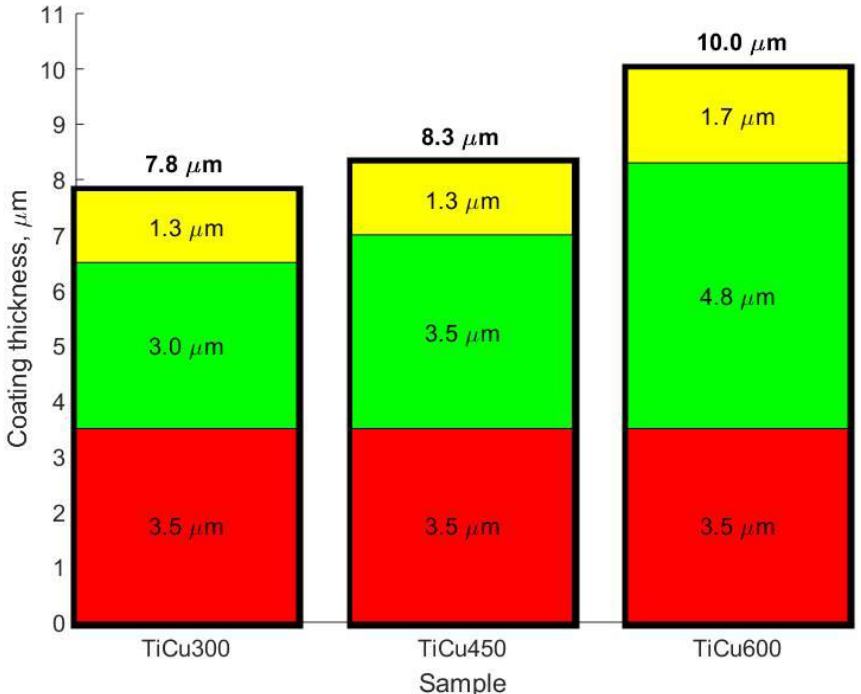
Figure 8. Layer thicknesses of the porous coatings determined on the basis of the GDOES analysis for the first stage of the studies; yellow color—porous layer, green color—semi-porous layer, and red color—transient layer.